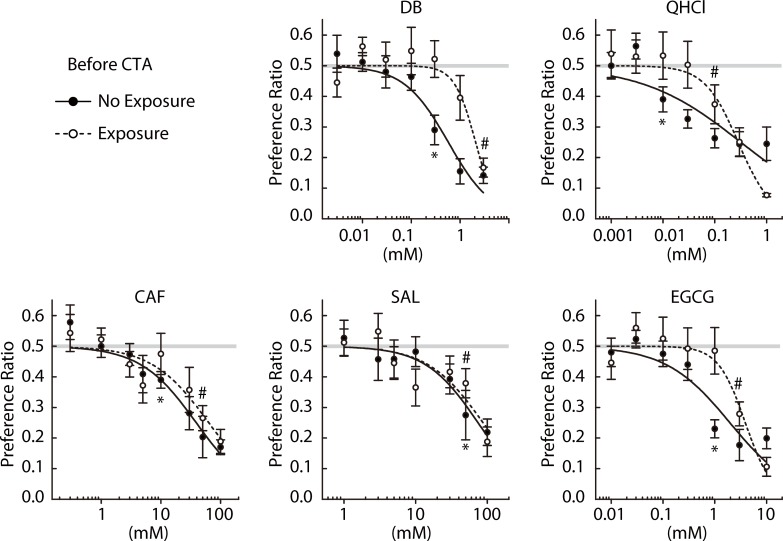
Two-bottle preference ratios for concentration series of DB (n = 8), QHCl (n = 7), CAF (n = 8), SAL (n = 8), and EGCG (n = 8) measured after a 3-week period of exposure to the same bitter compound (open circles) superimposed on those measured without the exposure period (closed circles).# and * indicate the lowest concentrations at which preference ratios fell significantly (p < 0.05) below indifference (0.5) before and after the long bitter exposure, respectively. Solid and dashed lines represent curves fit to the average ratios for the NE and E groups, respectively. Gray lines represent the indifference level (0.5).